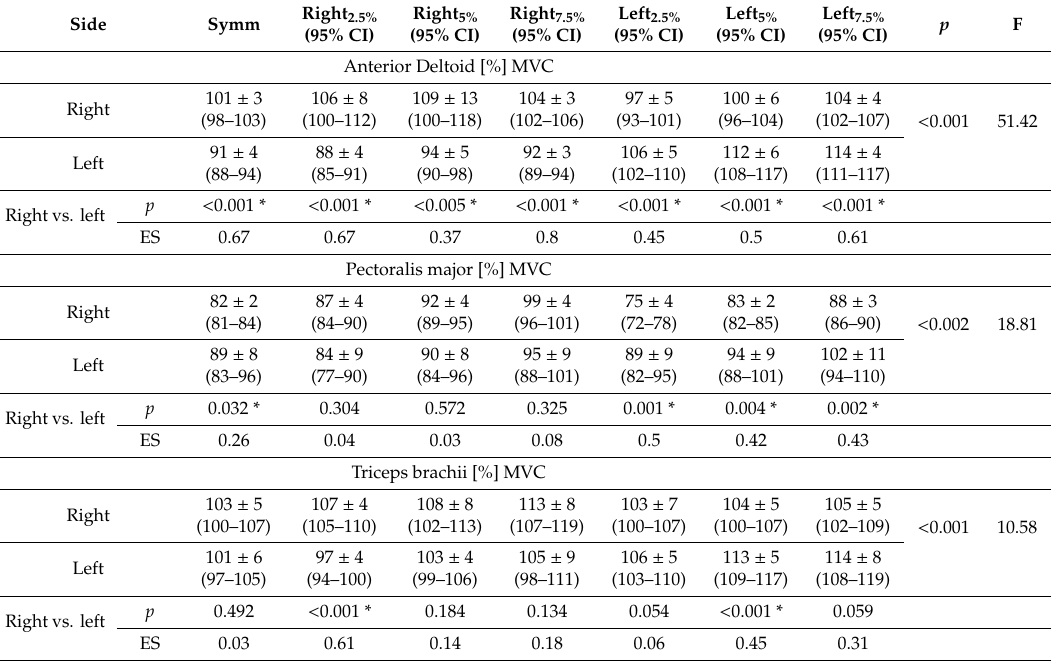
Table 1. Post-hoc comparisons between both sides of the body for all measured loads.